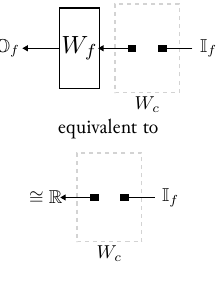
Figure 1: Example of compositional equality derived through a string diagram.